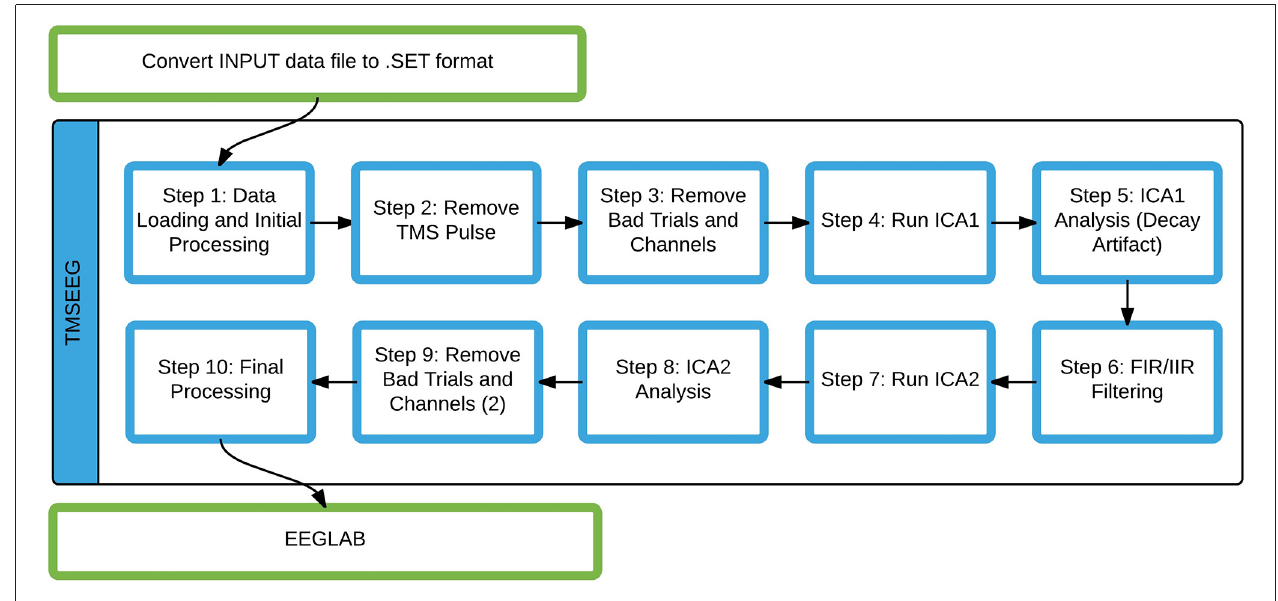
FIGURE 3 | The TMSEEG data processing workflow. Steps highlighted by blue boxes are modular functions within the TMSEEG processing workflow. The program takes an input file in .SET format (conversion done in EEGLAB), creating intermediate datasets after each step for easy reprocessing.